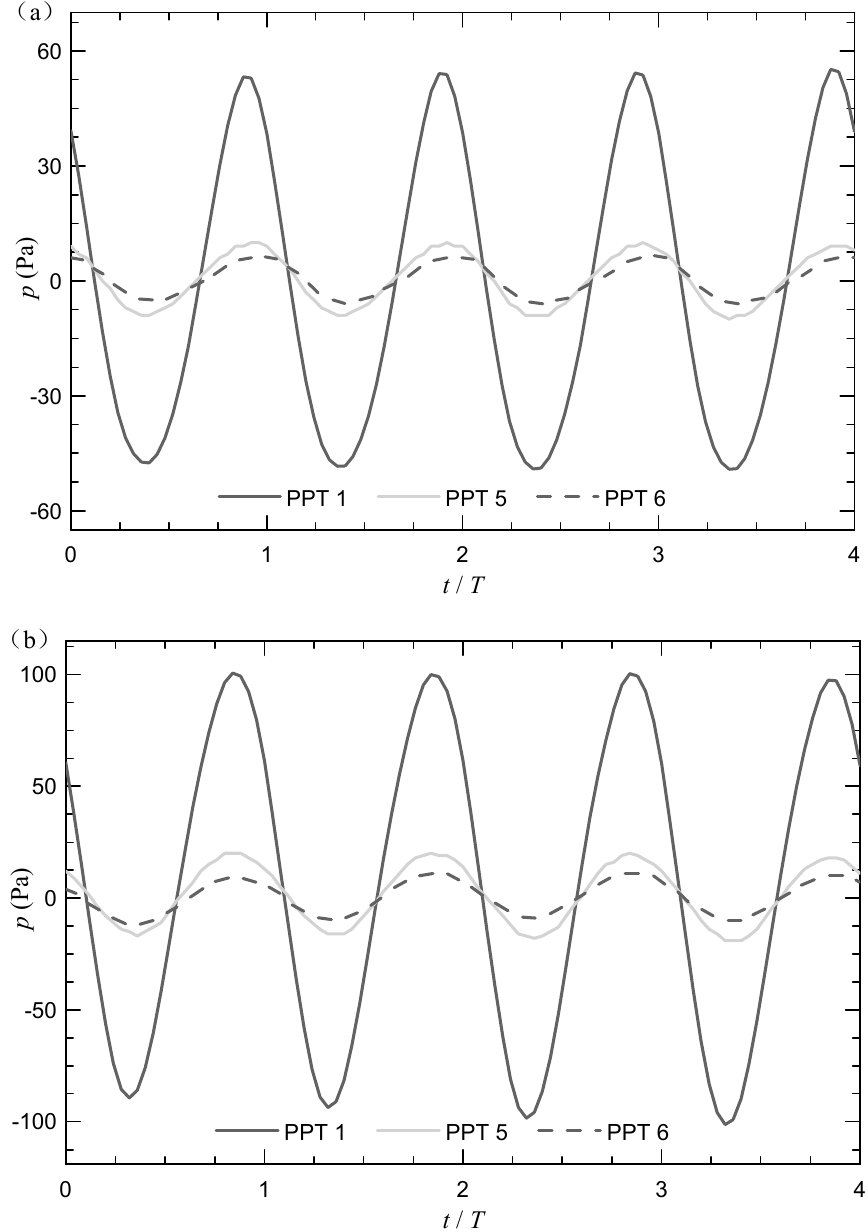
Figure 10. Time series of excess pore pressure measured with PPT1, PPT5 and PPT6 in ( a ) test 9 (Waves: H = 10 cm, T = 2.5 s; Mat foundation: position B; No current) and ( b ) test 10 (Waves: H = 10 cm, T = 2.5 s; Mat foundation: position B; Current: v c = 0.22 m/s ).